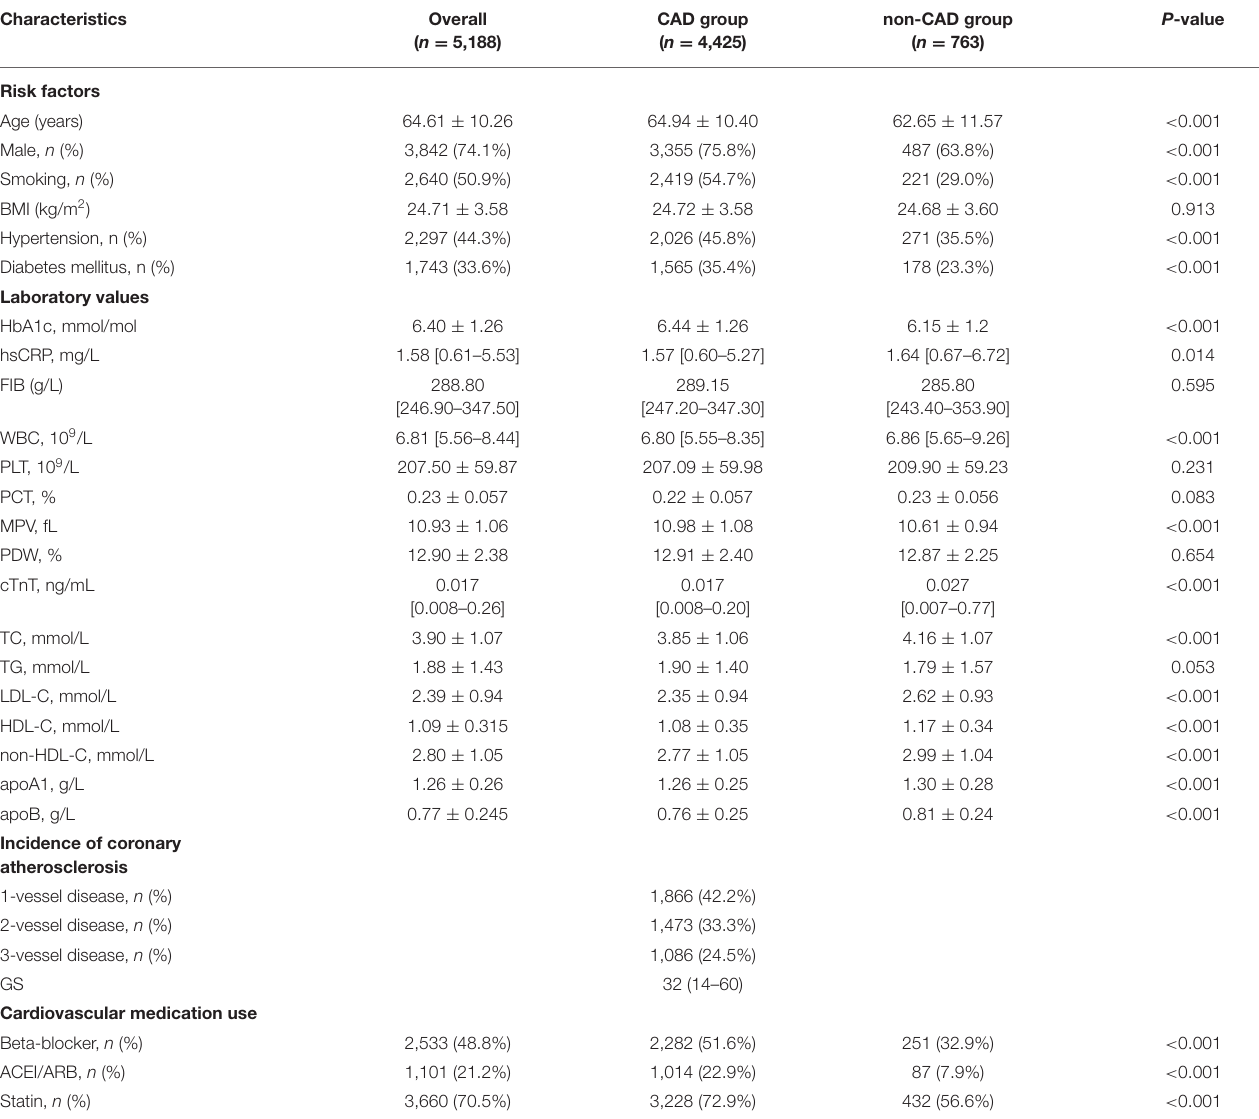
TABLE 1 | Baseline demographic and clinical characteristics of study subjects who underwent CAG.